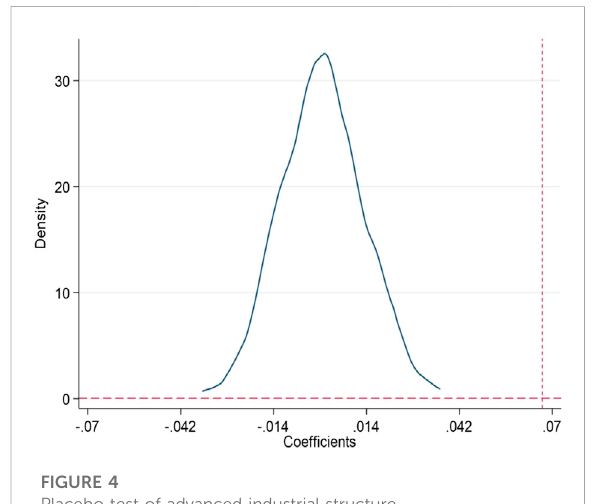
FIGURE 5 Placebo test of rationalization of industrial structure.